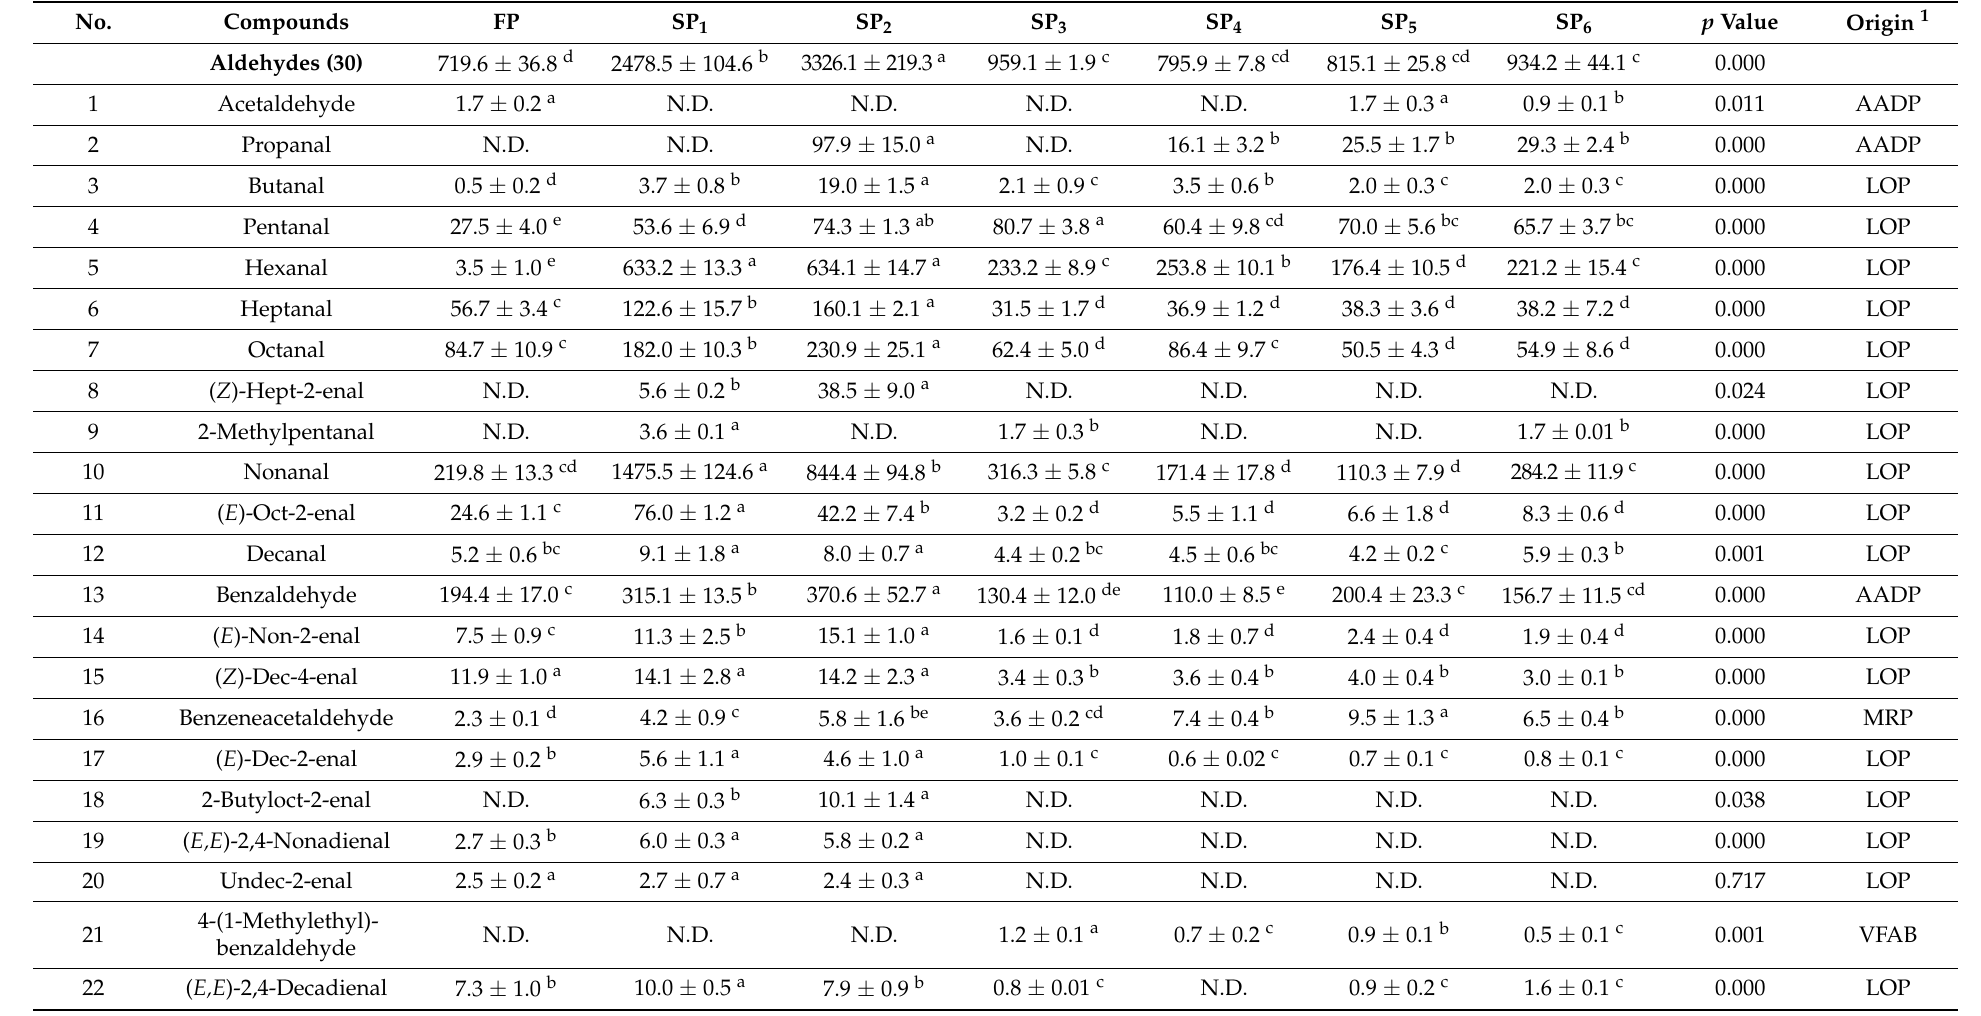
Table 2. Concentrations and origin of volatile compounds of the fresh and stewed